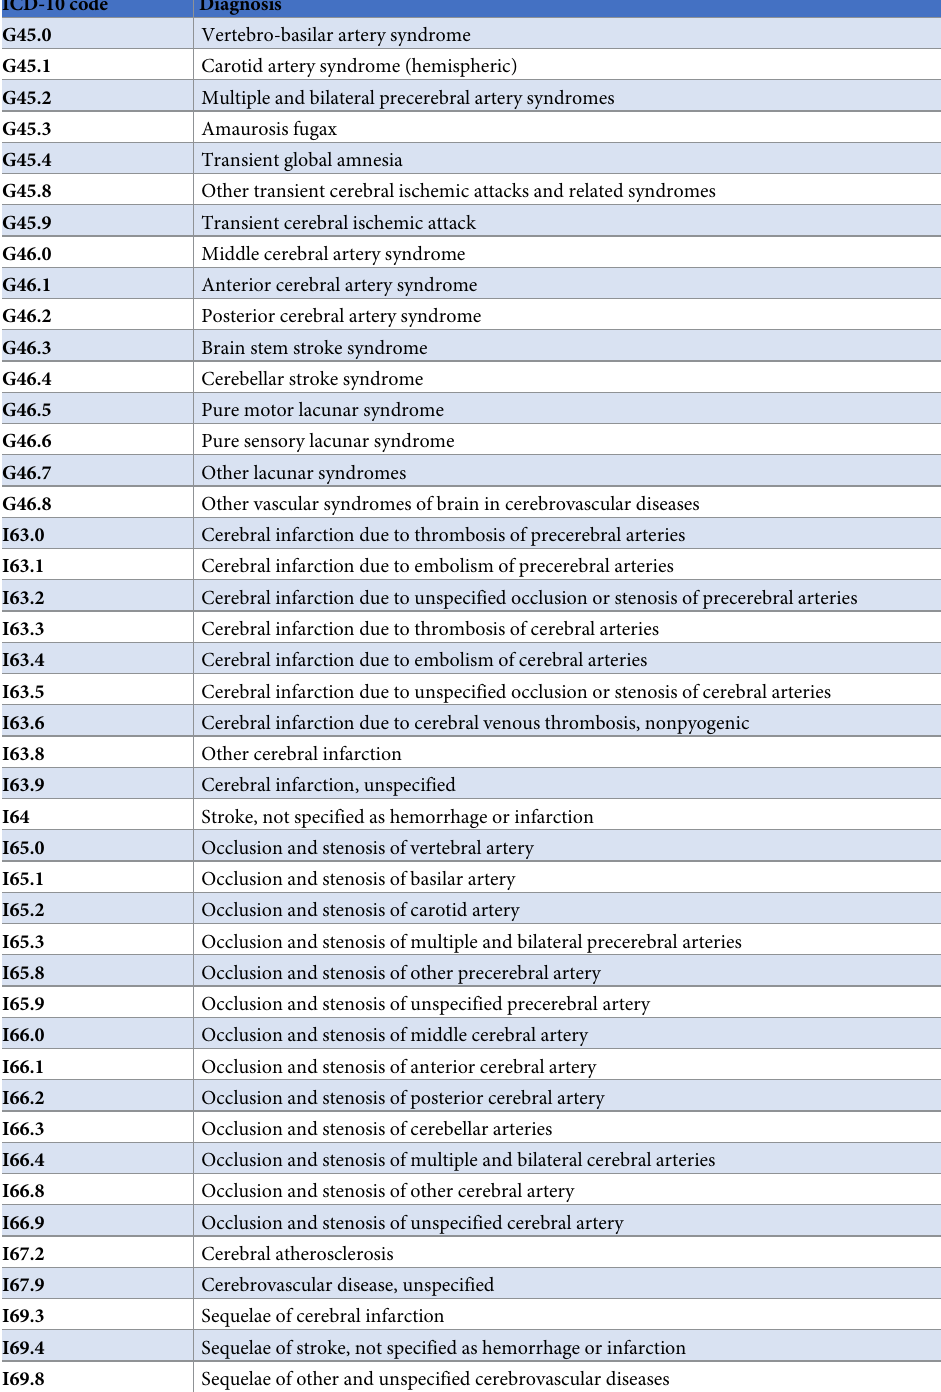
Table 1. List of ICD-10 codes included as cerebrovascular disease